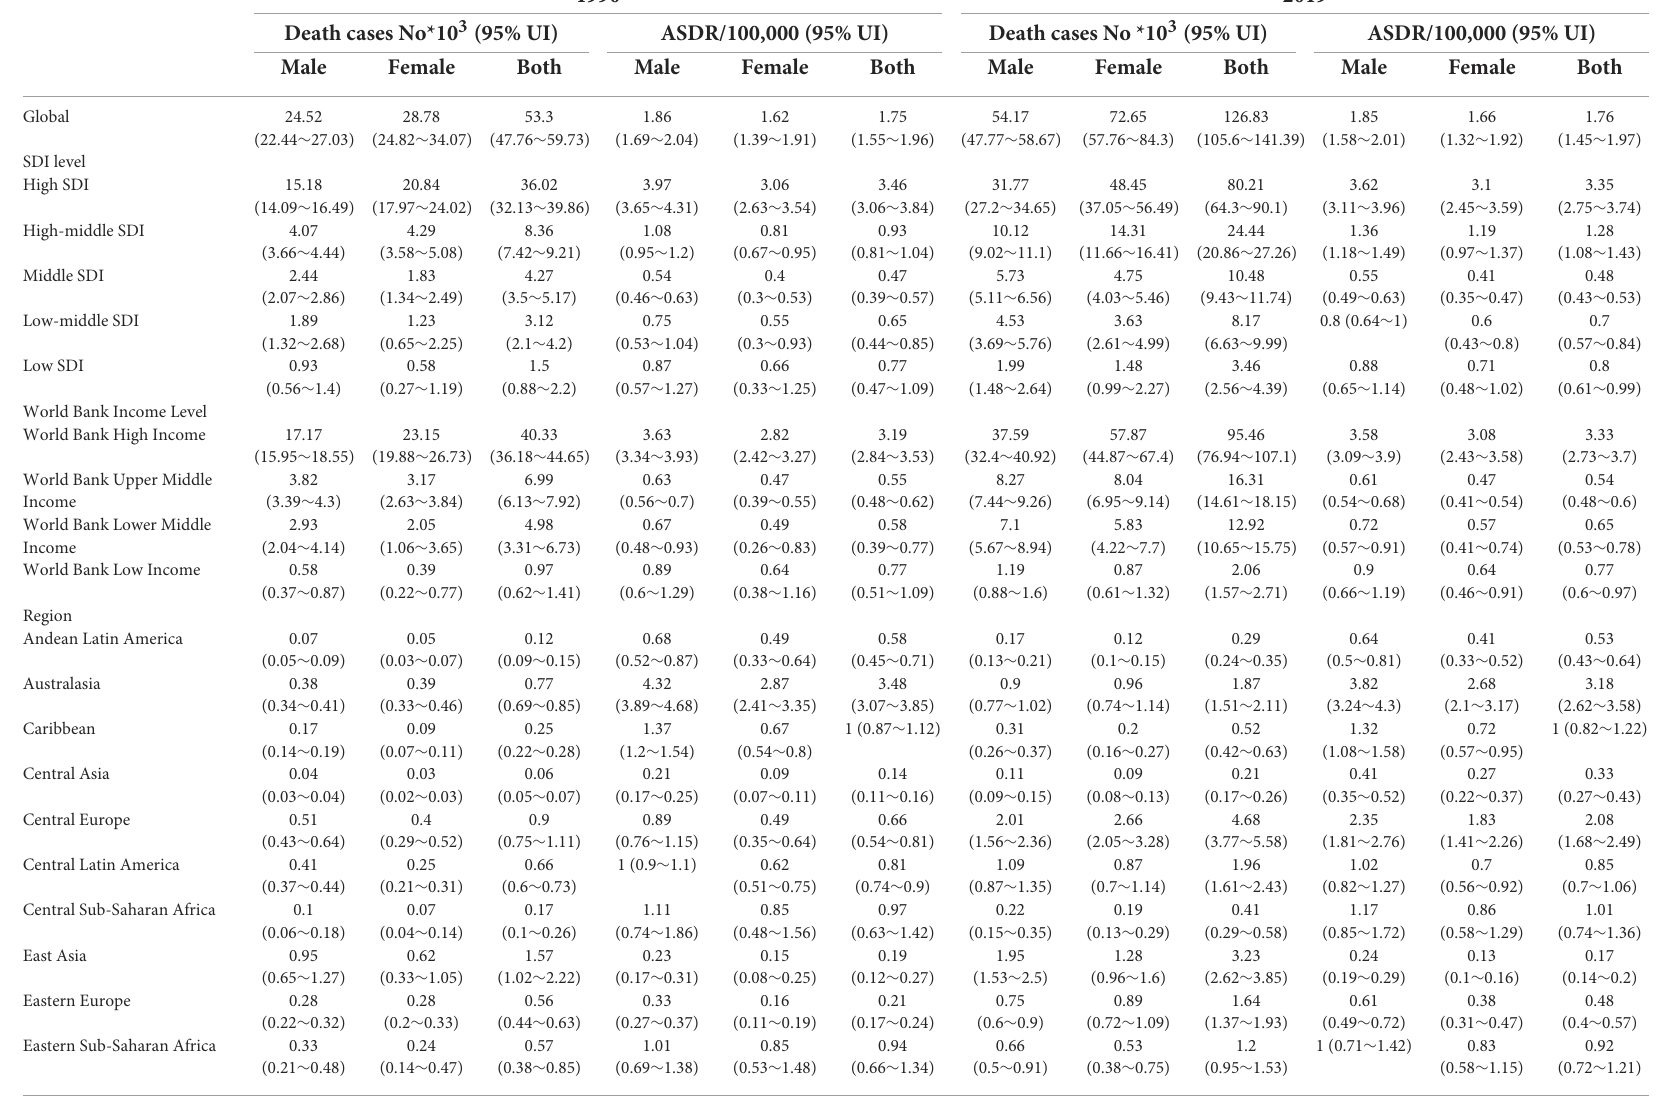
TABLE 3 The death of CAVD in